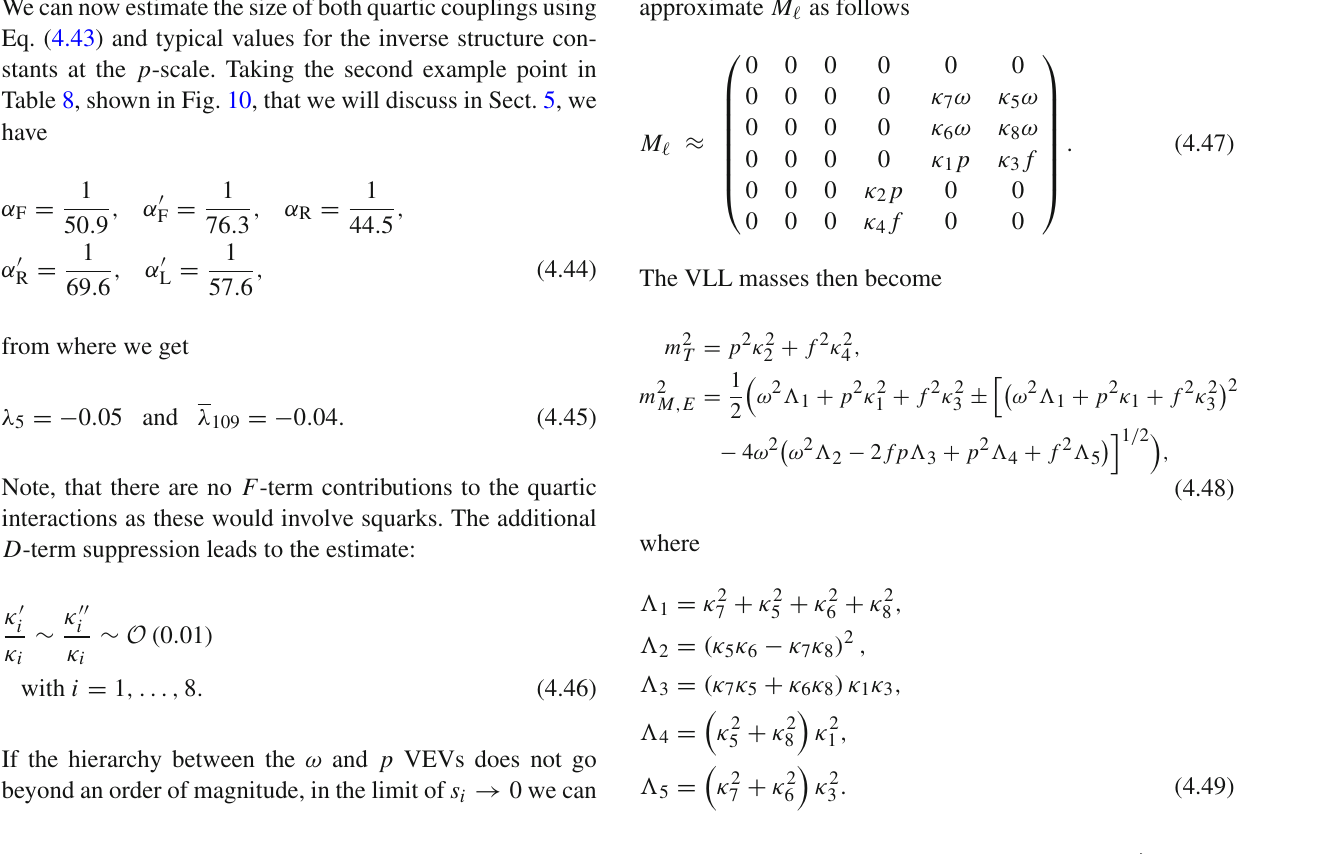
for the S L , R , F propagators, or to y 31 , 37 , 43 – for the T L , R , F prop- y L , R , F 25 agators, respectively. For more details on the corresponding Yukawa (bottom-right dia- 1 operators, see Appendix